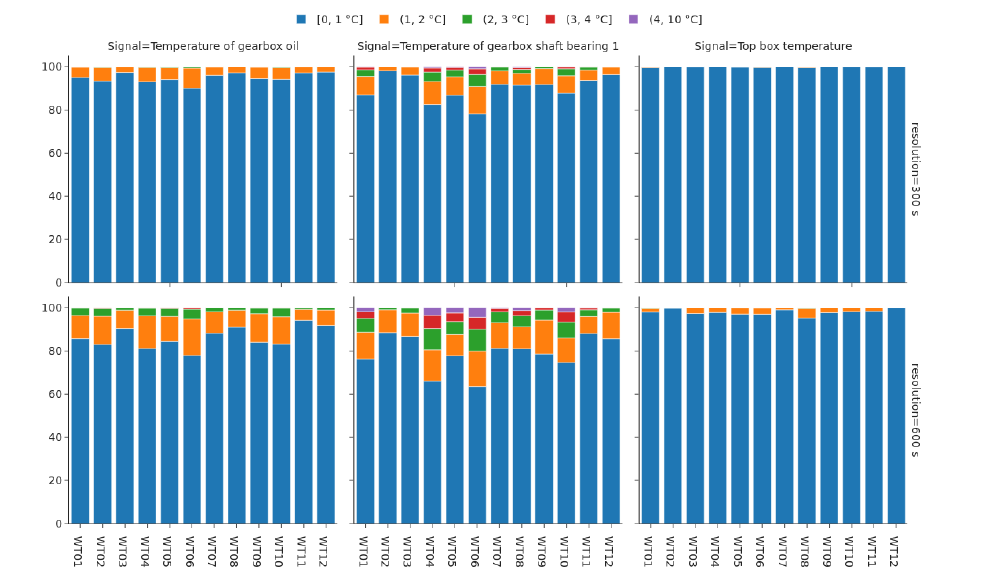
Figure 7. Information loss results subdivided into all wind turbines for the temperatures of Figure 6. Two time resolutions are provided: 300s in the top row, 600s in the bottom row. Error bins are temperature intervals measured in degrees